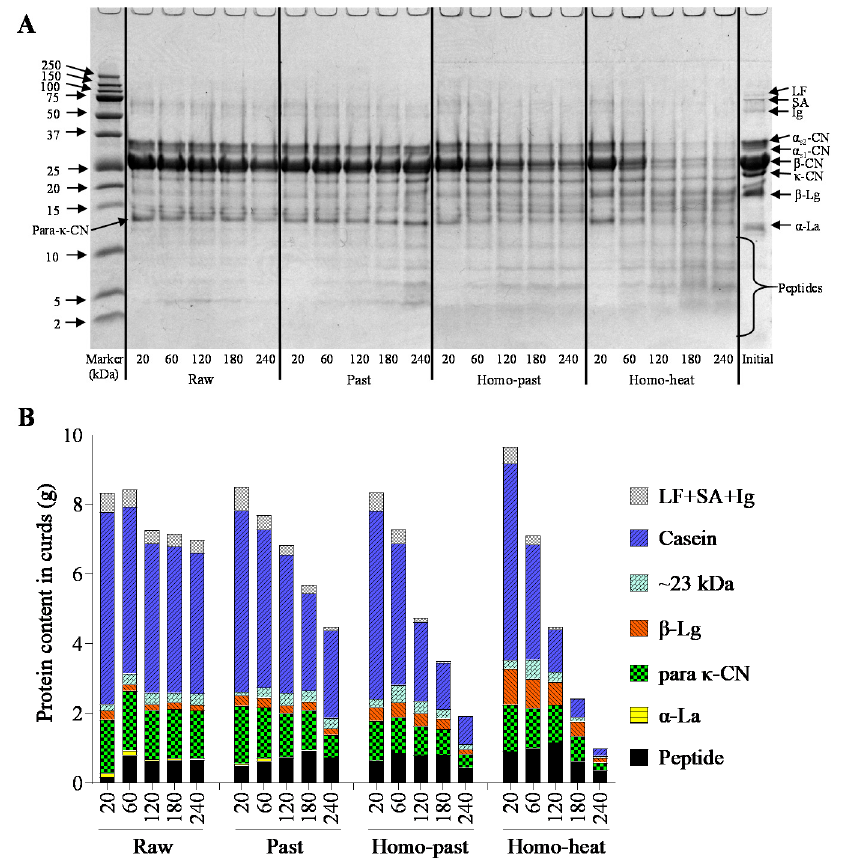
Figure 6. ( A ) Reducing tricine SDS-PAGE patterns and ( B ) protein contents of curds obtained from raw, pasteurized (Past), homogenized and pasteurized (Homo–past), and homogenized and heated (Homo–heat) sheep milks. The numbers (20, 60, 120, 180, 240) refer to different gastric emptying times (min). Initial refers to before digestion. The protein concentration in each sample for the tricine SDS-PAGE was 1 mg/mL.